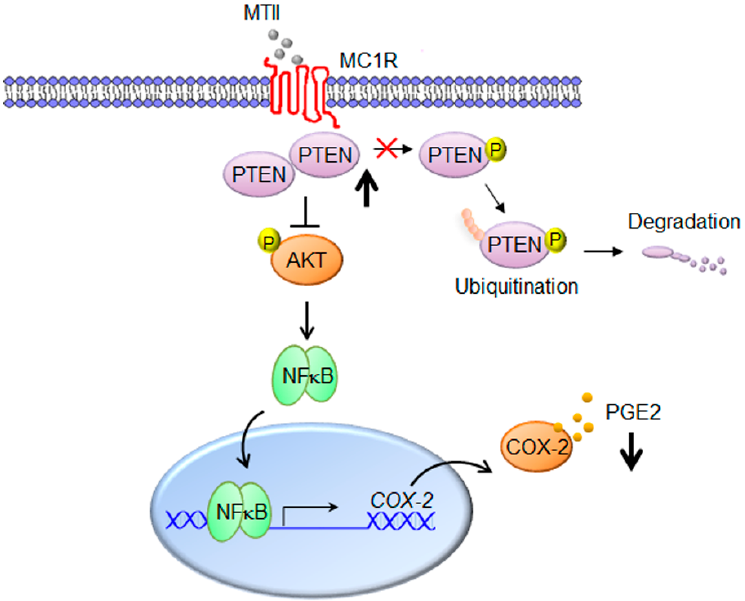
Figure 6. The working model for MTII-mediated melanoma suppression via PTEN upregulation and COX-2 / PGE2 inhibition. After binding to MC1R, MTII elevates the cellular PTEN levels by blunting the PTEN degradation pathways, such as phosphorylation and ubiquitination. Subsequently, the escalated PTEN expression perturbs the AKT activation and NF κ B-mediated COX-2 expression and PGE2 release.